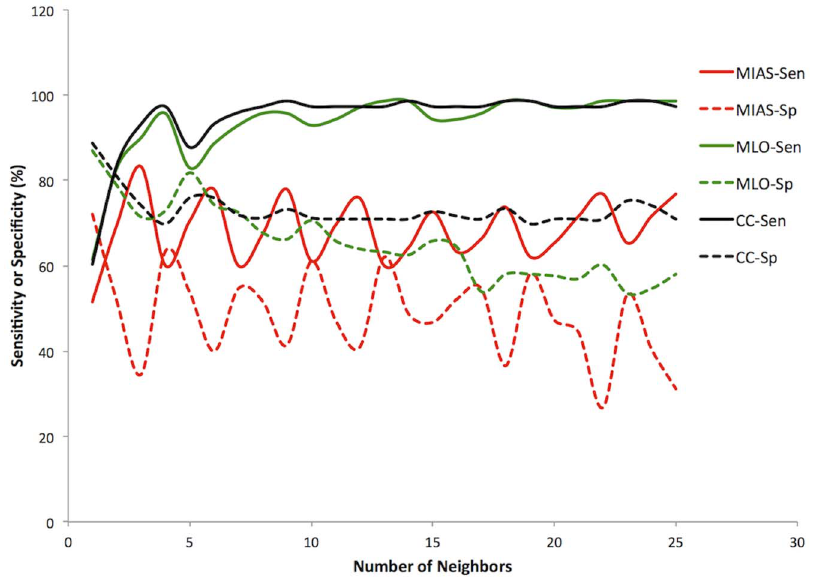
Figure 3. Prior probability weighted KNN classifier. Sensitivity (Sen, solid lines) and specificity (Sp, dashed lines) versus Number of Neighbors for all three datasets. MIAS (red), DDSM MLO (green), DDSM CC (black).